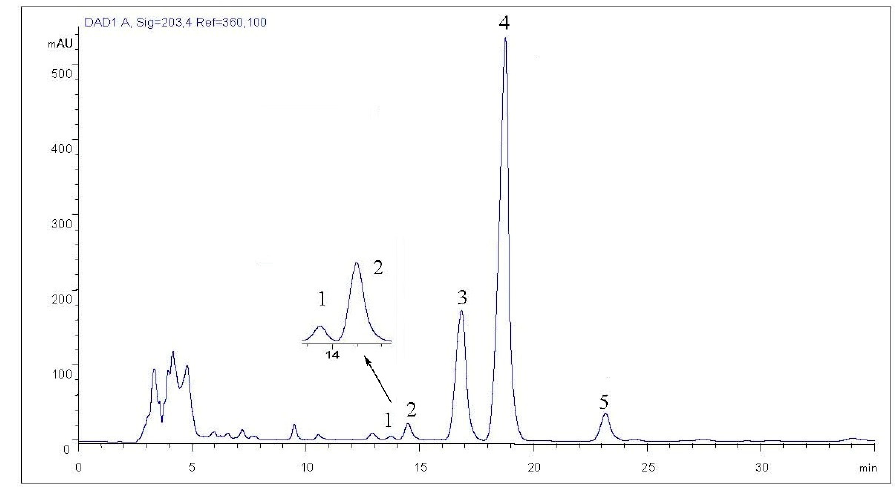
Figure 4. The chromatogram of ginsenoside fractions obtained from SPE with 80% methanol (acetonitrile/water = 53:47, flow rate 0.6 mL/min, column temperature 15 °C).